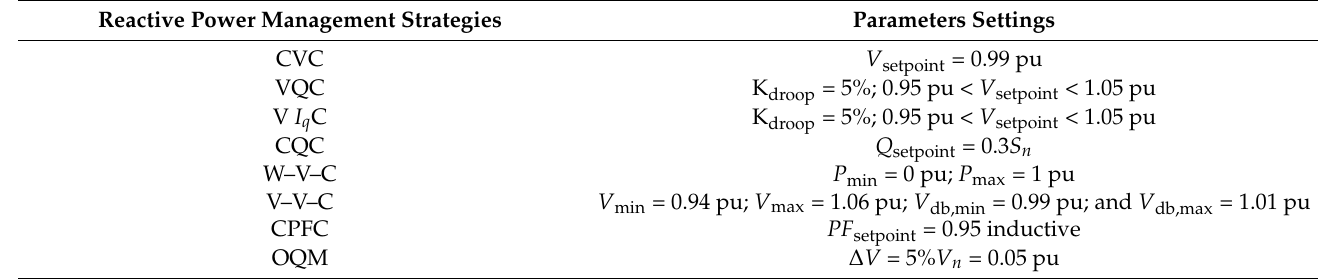
Figure 7. Schematic representation of the European MV distribution Benchmark network equipped with DER technologies (seven solar photovoltaic and one wind). Table 3. Parameters settings of the local and optimal-centralised reactive management strategies enabled at the smart converters.